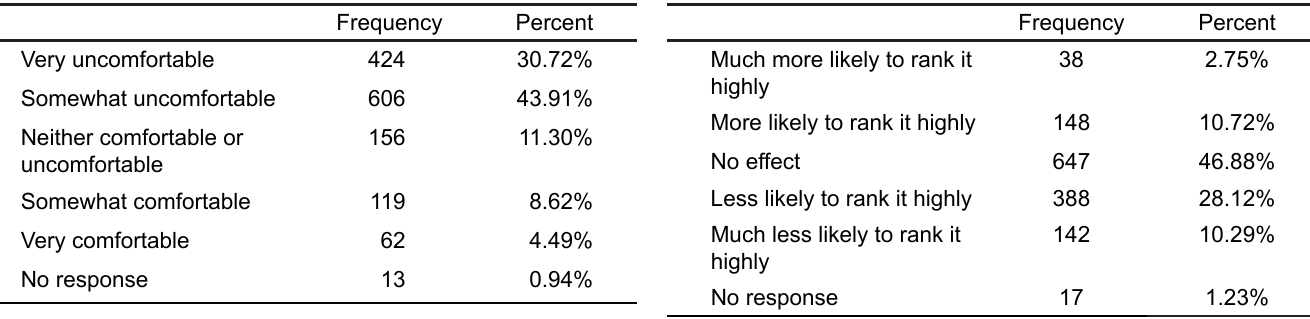
Table 3. Applicant effect on